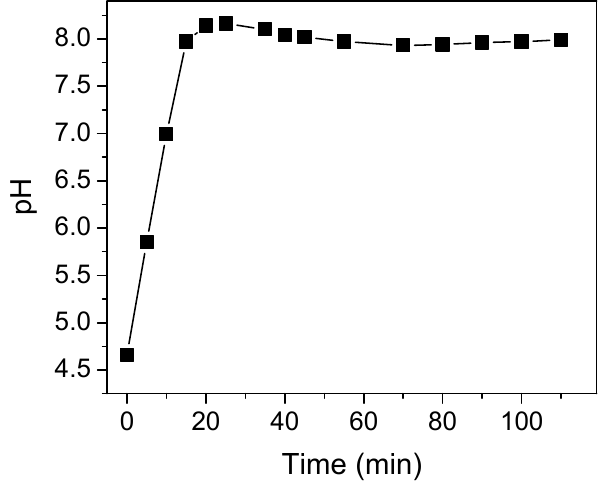
Figure 1. pH variation of synthesis system with time on stream.